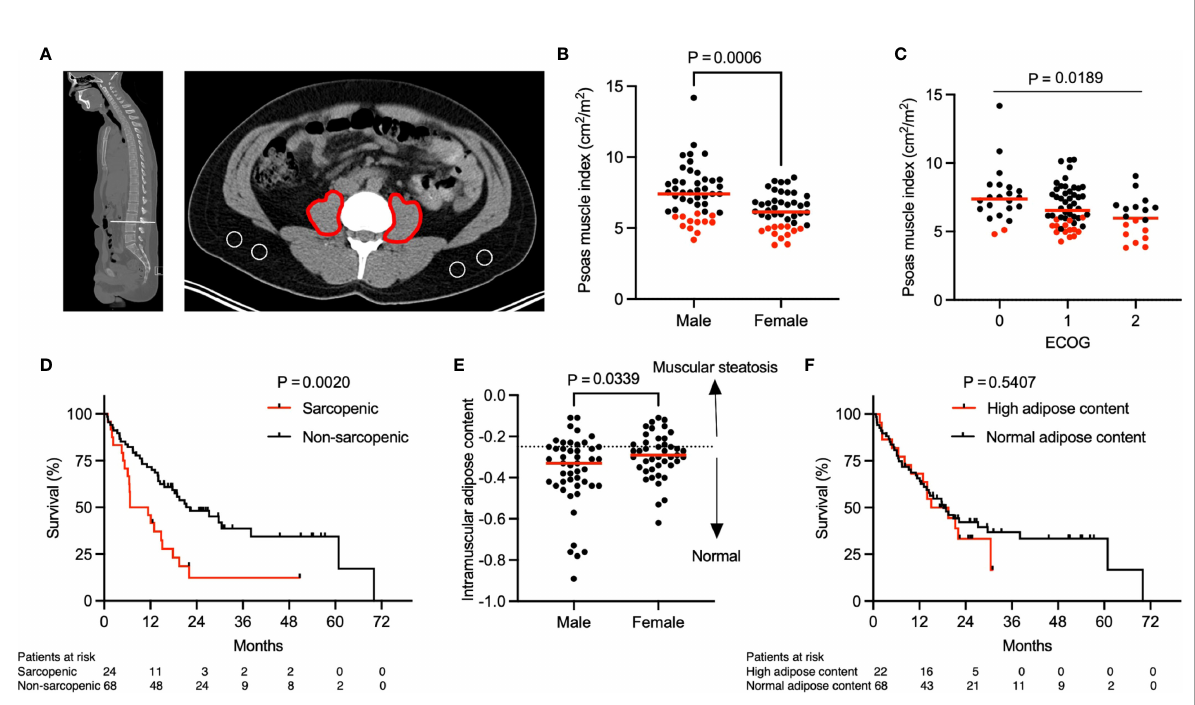
FIGURE 1 Association of sarcopenia with overall survival. Representative (A) sagittal and transversal computed tomography (CT) images at the inferior aspect of the third lumbar vertebra. Red markings indicate the cross-sectional area of both psoas muscles and areas encircled in white indicate subcutaneous fat. (B) Psoas muscle index (PMI) strati fi ed by gender (n = 92). P value calculated using the Mann-Whitney U test. (C) Patient ECOG score in relation to PMI (n = 92). P value calculated using the Kruskal-Wallis test. (D) Kaplan-Meier curve depicting survival analysis based on sarcopenia. (E) Intramuscular adipose content (IMAC) strati fi ed by gender (n = 90). Two patients were excluded from analysis due to almost complete absence of subcutaneous fat tissue on abdominal imaging. Dotted line represents the threshold between normal and increased intramuscular adipose content based on sex-speci fi c 25 th percentile. P value calculated using the Mann-Whitney U test. (F) Kaplan-Meier curve depicting survival analysis based on IMAC. P values in (D, F) were calculated with the log-rank test. Each tick mark on the Kaplan-Meier curve represents a censored event. Each data point in (B, C, E) represents an individual patient. Red dots in (B, C) indicate sarcopenic patients with a PMI value below the sex-speci fi c 25 th percentile and cut offs were 6.03 cm 2 /m 2 for males and 5.11 cm 2 /m 2 for females. Red lines represent the median of the